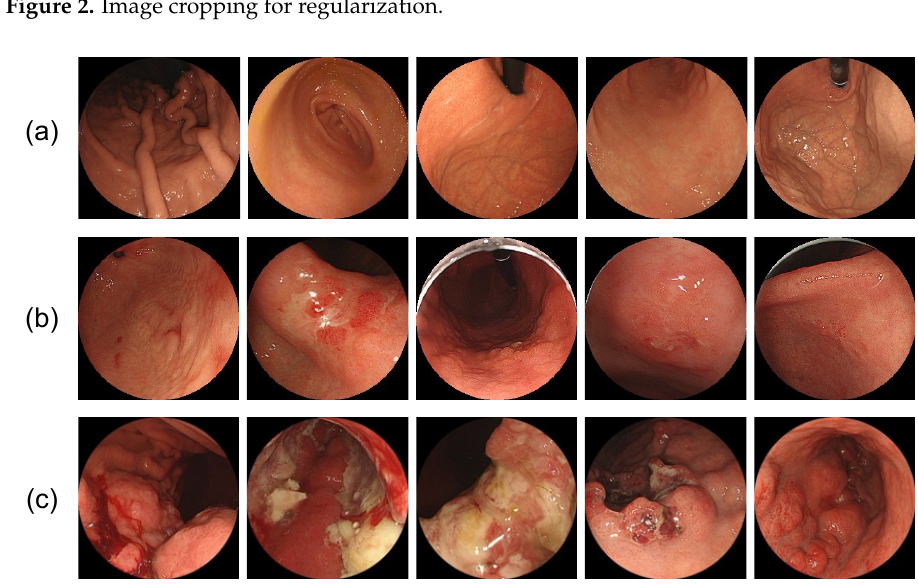
Figure 3. Sample images of the image dataset. ( a ) healthy subjects; ( b ) early gastric cancer; ( c ) advanced gastric cancer.